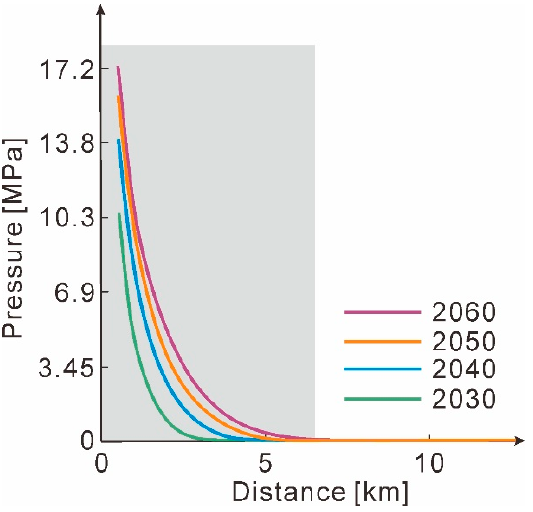
Figure 8. The excess pore pressure variations with horizontal distance from an injection well at a reference depth of 2600 m.